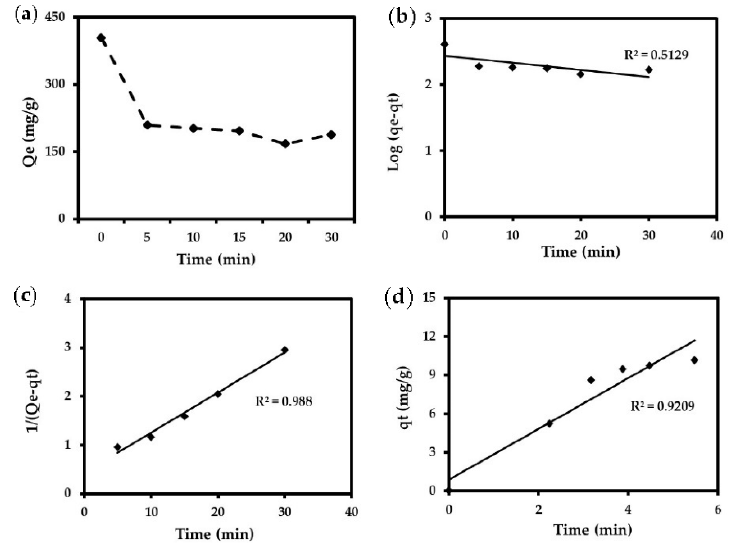
Figure 6. ( a ) Removal of Cr (VI) under the following conditions: 1 g of JTT, Cr (VI) = 200 mg/L, T = 25 °C. Evaluation of kinetic models using: ( b ) Pseudo-first-order kinetic model, ( c ) Pseudo-second-order kinetic model, ( d ) Intraparticle diffusion model.